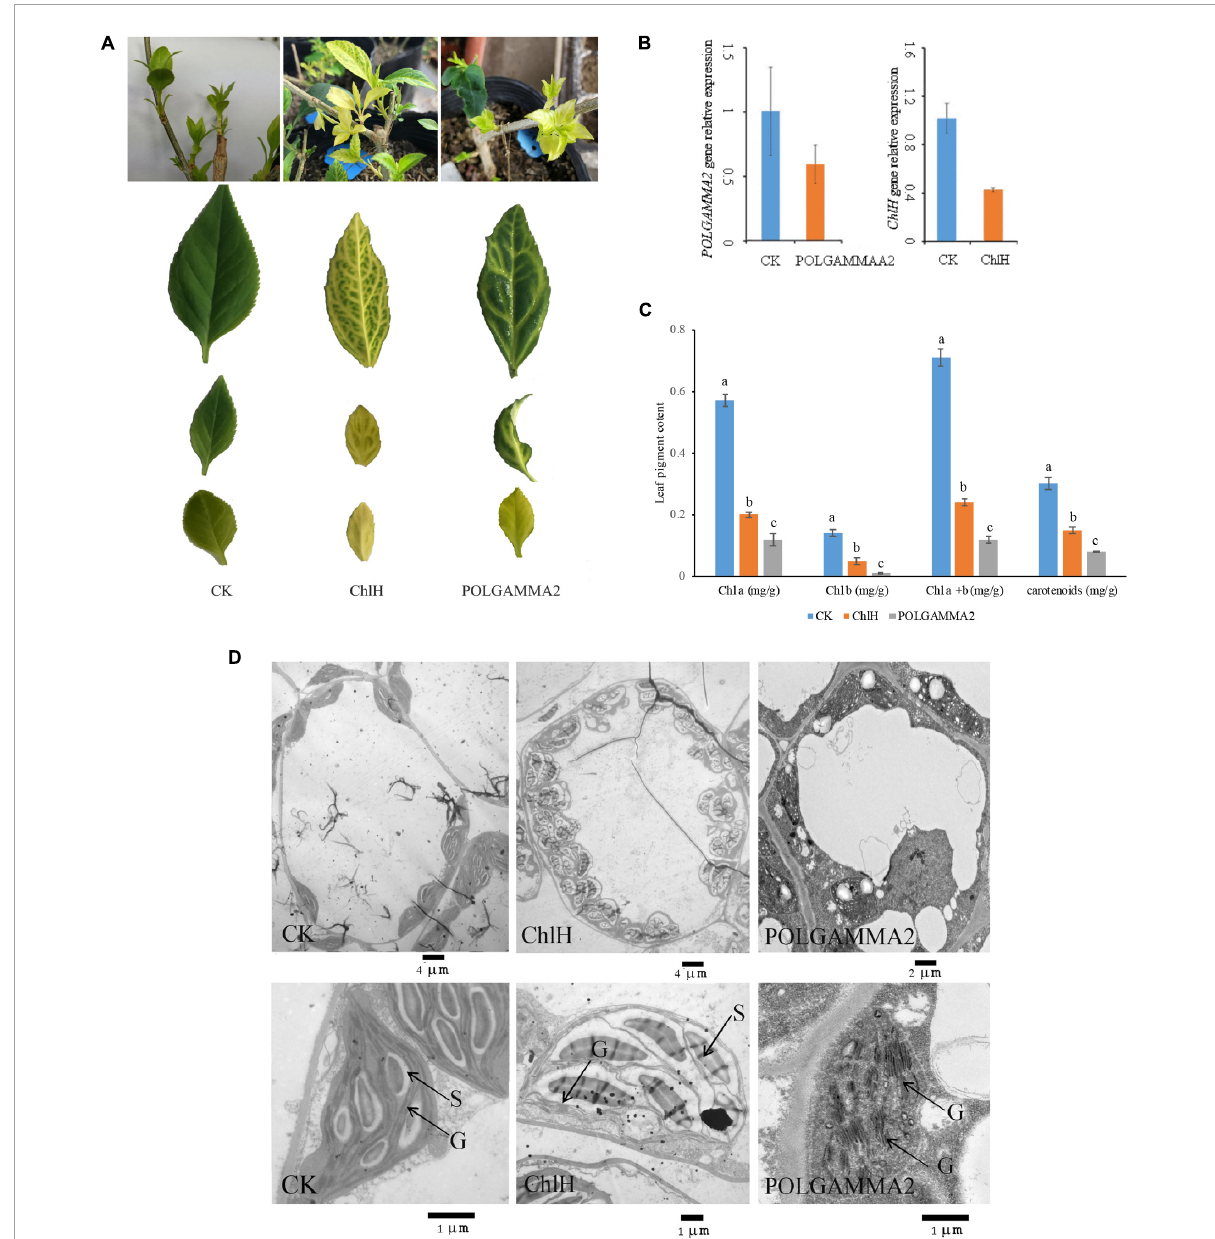
FIGURE3 The leaf color and anatomy change in green-leaf Forsythia plants with candidate genes transiently silenced. (A) The leaf color of CK (vector control), FsChlH -silenced, and FsPOLGAMMA2 -silenced plants; (B) the relative gene expression of POLGAMMA2 and ChlH in FsPOLGAMMA2 -silenced and FsChlH -silenced plants, respectively; (C) the content of Chl a , Chl b , total Chl, and carotenoid in CK, FsChlH -silenced, and FsPOLGAMMA2 -silenced Forsythia plants; (D) the chloroplast ultrastructure of CK, FsChlH -silenced, and FsPOLGAMMA2 -silenced